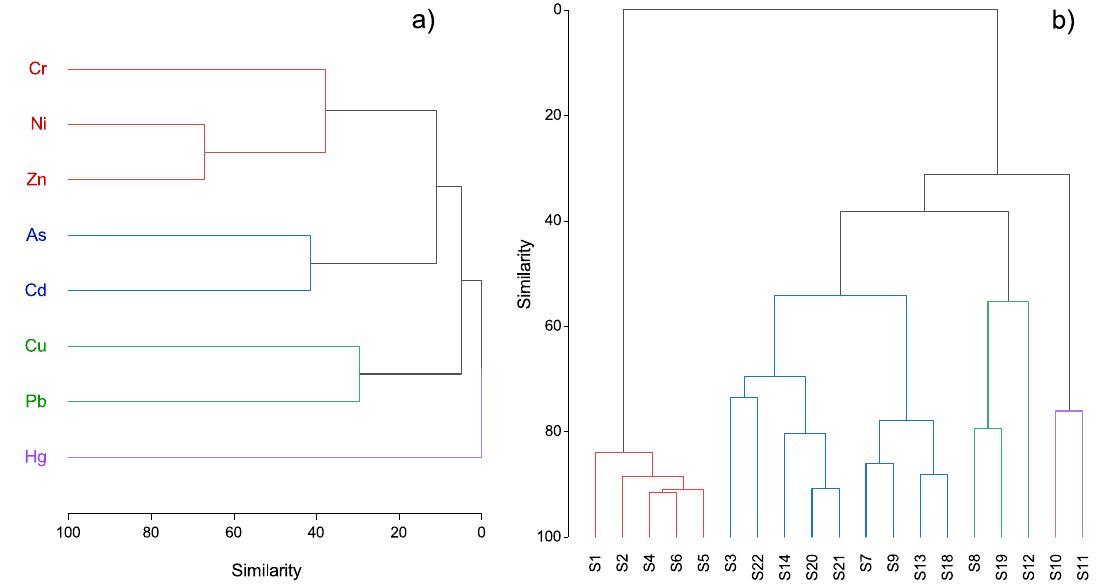
Figure 3. Dendrogram of hierarchical cluster analysis among heavy metals ( a ) and sites ( b ) (Euclidean distance, Wards method).